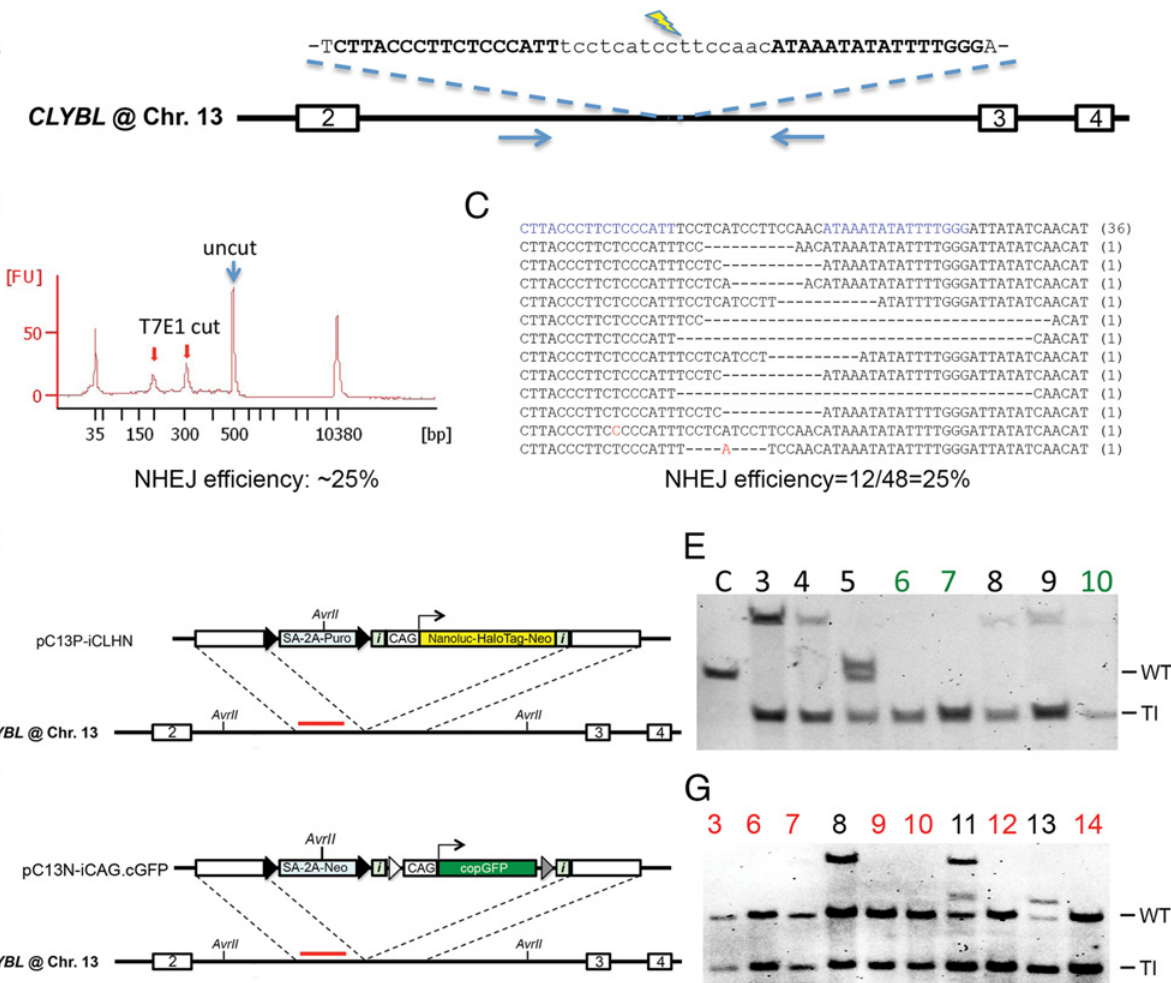
Figure 1. TALEN Targeting of a novel safe-harbor in the CLYBL gene. (A) Sequence of CLYBL-TALEN target site at intron 2 of CLYBL . Exon numbers are indicated in the boxes of genomic locus. Bold fonts indicate TALEN binding sequences: left CLYBL-TALEN binds 5 ’ -CTTACCCTTCTCCCATT; right CLYBL-TALEN binds 5 ’ -CCCAAAATATATTTAT. Blue arrows indicate the primers for NHEJ assay. (B) Capillary electrophoresis plot from T7E1 assay indicates that our CLYBL TALENs have ~25% NHEJ efficiency based on the calculation: % gene modification = 100 × (1 − (1 − fraction cleaved)1/2), where fraction cleaved = T7E1 cut/(T7E1cut+uncut). Red arrows indicate T7E1 cleaved bands, blue arrow indicates uncut PCR band. (C) CLYBL TALEN activity estimated by targeted amplicon sequencing confirmed 25% (12 alleles out of 48) gene editing efficiency. Blue fonts are TALEN binding sequence. (D and F) Schematics of gene targeting at CLYBL safe-harbor on Chr. 13. The donors shown have the same reporter cassettes as in Fig. 1C and 1E, including insulator-flanked CAG-copGFP or CAG-iCLHN, except that CLYBL homology arms were used and pC13N-iCAG.cGFP has neomycin resistant gene (Neo) instead of Puro. Red lines indicate CLYBL probe used with AvrII digestion in Southern blot analysis. (E and G) Southern blots of pC13P-iCLHN targeted (E) and pC13N-iCAG.cGFP targeted (G) NCRM5 iPSC clones. Because the same position of AvrII sites in both donors and the ability of CLYBL probe to recognize WT, TI and RI, WT band is 5.4kb due to two AvrII sites in intron 2, TI band is 3.2kb due to donor-introduced AvrII site, and any other additional bands are RI. Clones with 1TI-only are indicated in red numbers; clones with 2TI-only are indicated in green numbers. Clone “ C ” indicate the control untargeted cells.